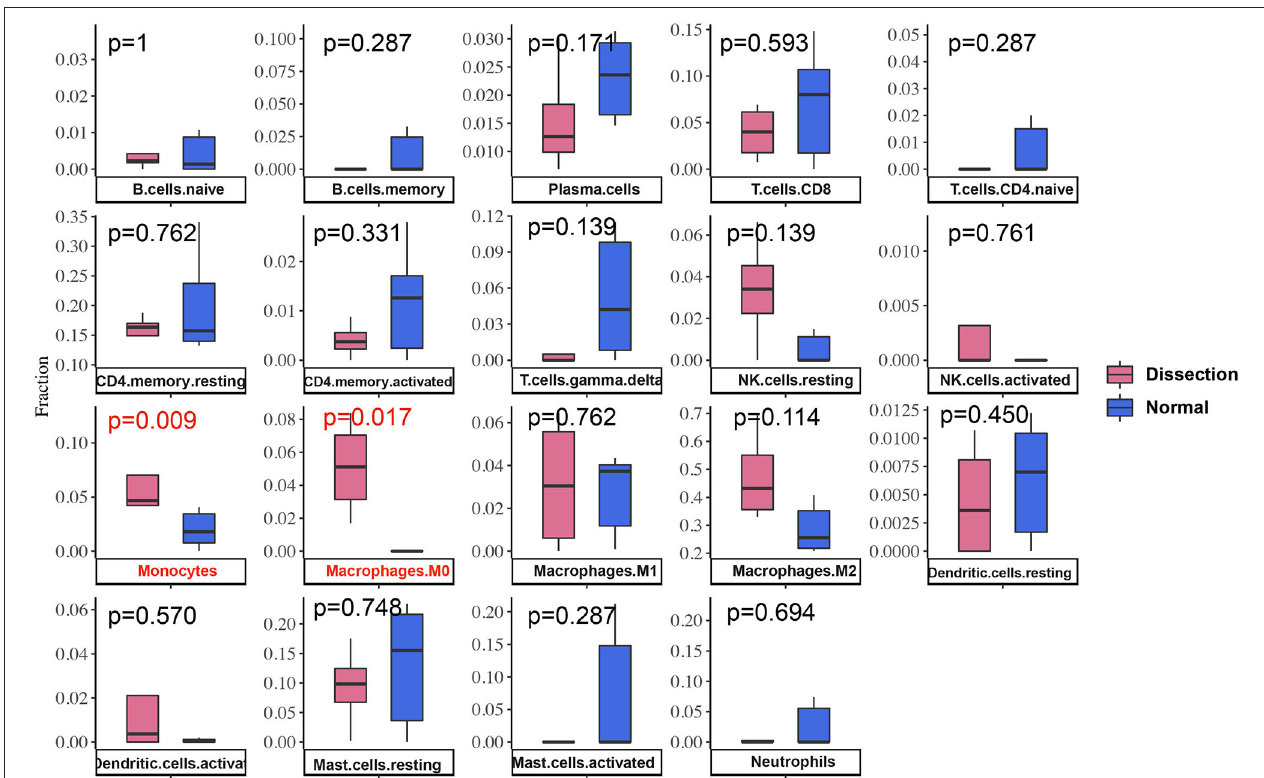
FIGURE 7 | Differences in immune infiltration between AAD samples and non-AAD samples. Red represents AAD samples, and blue represents non-AAD samples. The x axis represents the type of immune cells, and the y axis represents the fraction of immune cells. The Wilcox test was used to analyze differences in immune infiltration. The fraction of monocytes and macrophages. The proportion of M0 macrophages was significantly higher in AAD samples than in non-AAD